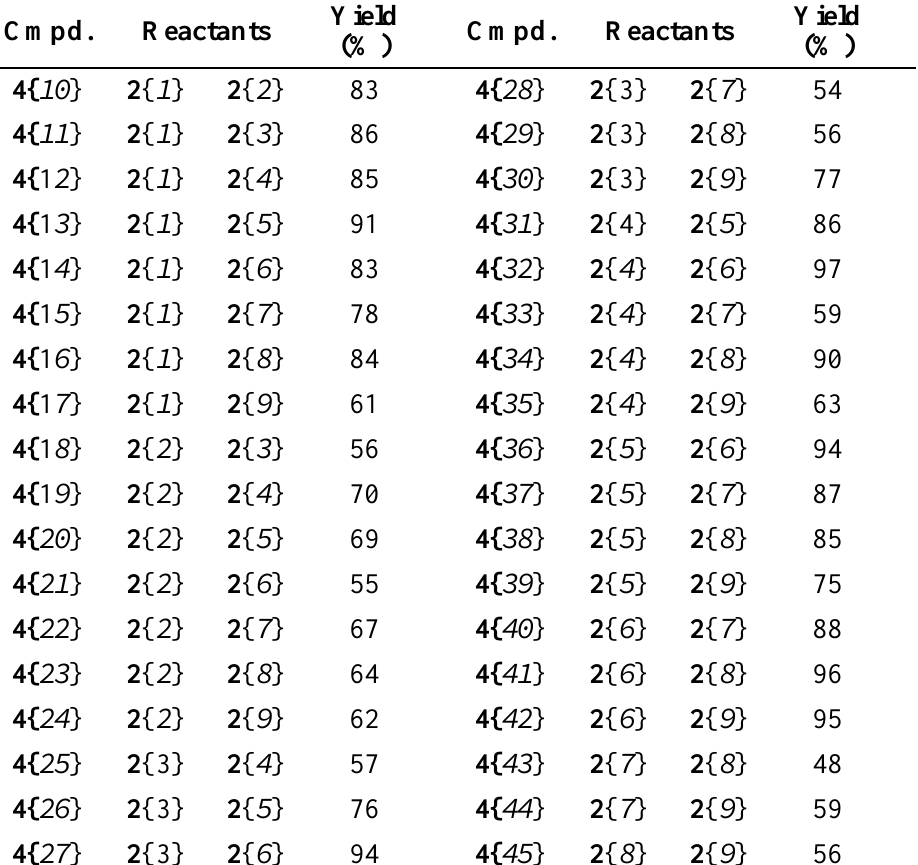
Table 3. Dissymmetrically-disubstituted Amino Acid Ester I45DCs, 4 { 10 - 45 }.